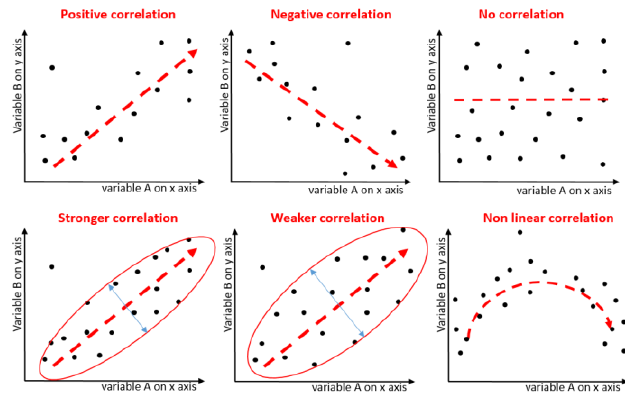
Figure 1. Correlation based on direction, form, and dispersion strength.